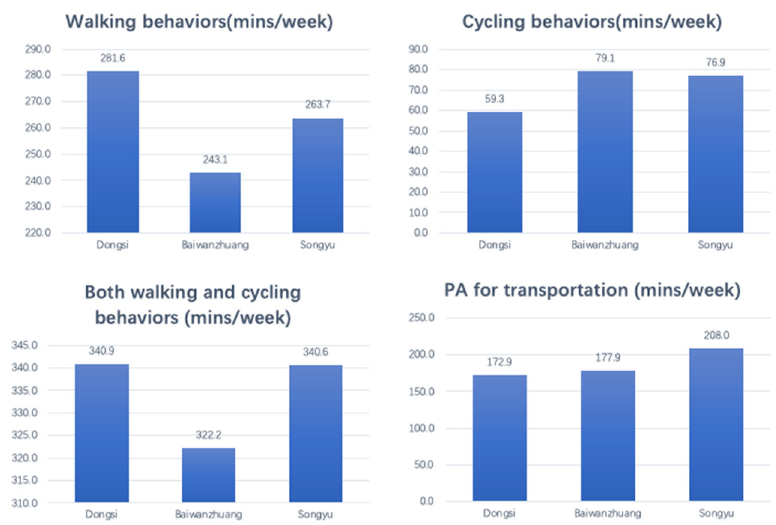
Figure 8. Physical Activities Durations in a general week in three neighborhoods.